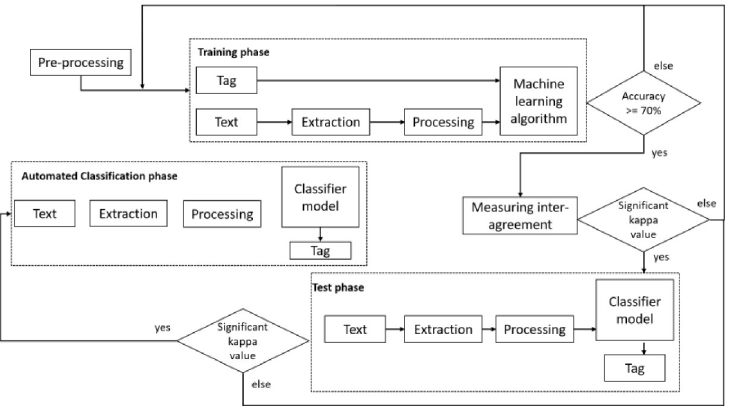
Fig 4. The overall sentiment analysis